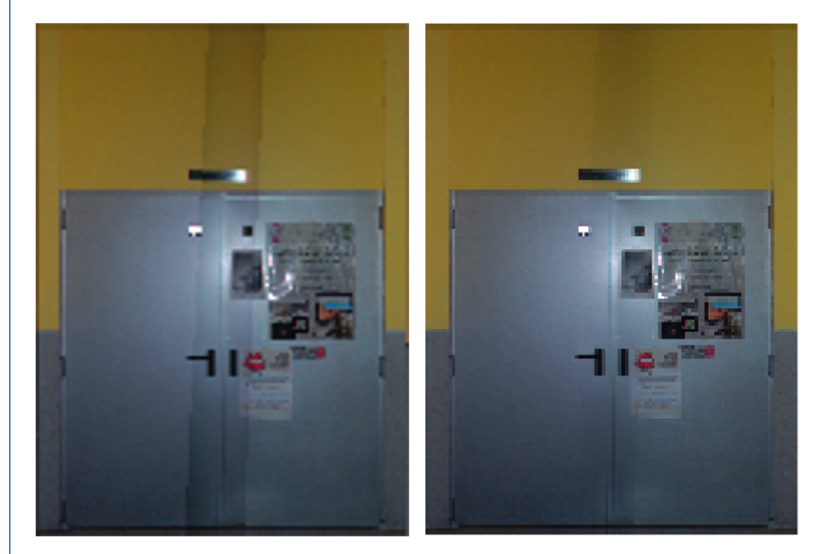
Figure 14. Left orthoimage presents edge seams as opposed to right orthoimage, where pixels are fused making the overlapping area transited from the first image to the second image